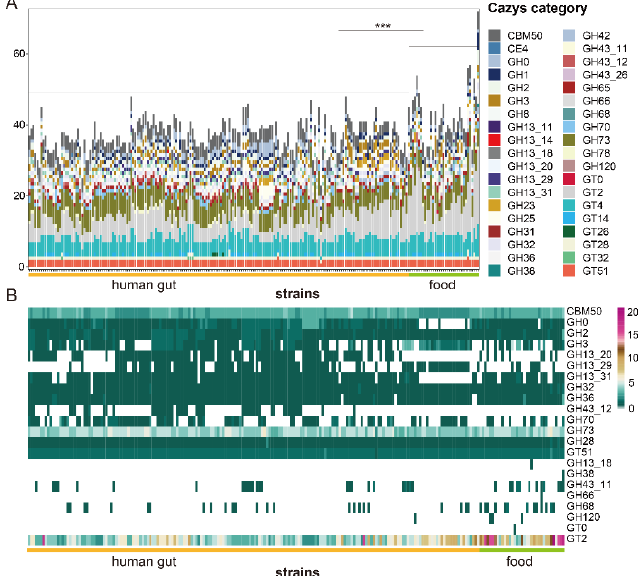
Figure 4. Genes encoding carbohydrate-active enzymes (CAZy) in the genome of L. fermentum strains isolated from human gut and food. ( A ) Stacked bar chart of carbohydrate-active enzyme (CAZy) categories in the genome of L. fermentum derived from different sources and * indicate a significant difference in the number of CAZys between different group (*** p < 0.001); ( B ) heatmap of the number of specific CAZy categories in the genome of L. fermentum strains from human gut and food. (The items of CAZy category with LDA score greater than 2 using linear discriminant analysis effect size analysis are listed).